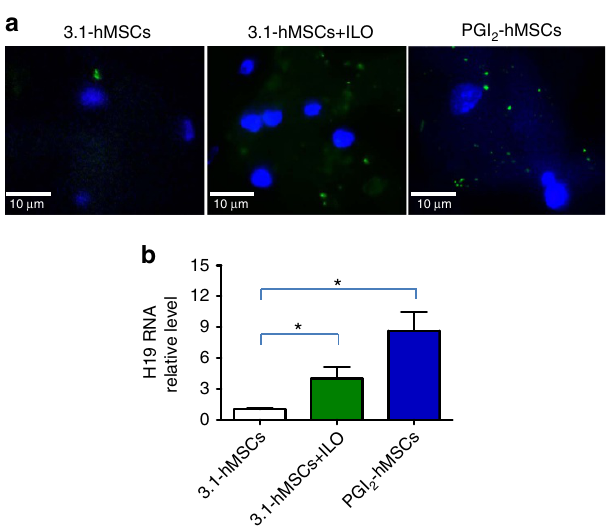
Figure 8 | Upregulation of H19 lncRNA in ischaemic hindlimbs treated with PGI 2 -hMSCs. ( a ) Representative images of H19 RNA fluorescence in situ hybridization in gastrocnemius muscle sections at 3 days after 3.1-hMSC, 3.1-hMSC þ ILO or PG 2 -hMSC injections. We used a fluorescein- tagged H19 FISH probe that specifically targets endogenous H19 lncRNA, resulting in intense intracellular green fluorescent particles. We found a higher expression of host H19 lncRNA in PGI 2 -hMSC- and in 3.1-hMSC þ ILO-treated muscles than in 3.1-hMSC-treated muscles ( n ¼ 3 mice per group). All the sections were counterstained with 4,6-diamidino-2-phenylindole (DAPI) to localize nuclei. ( b ) Quantitative RT–PCR showed a significant increase in H19 lncRNA levels in ischaemic gastrocnemius muscle 5 days after injections with 3.1-hMSCs þ ILO or PG 2 -hMSCs as compared with tissue samples injected with 3.1-hMSCs. * P o 0.05 by one-way ANOVA with Newman–Keuls post hoc test. Data are shown as mean ± s.e.m. from three independent assays. N ¼ 3 mice (male and female) per group. Mice were sex matched among the groups. Scale bar, 10 m